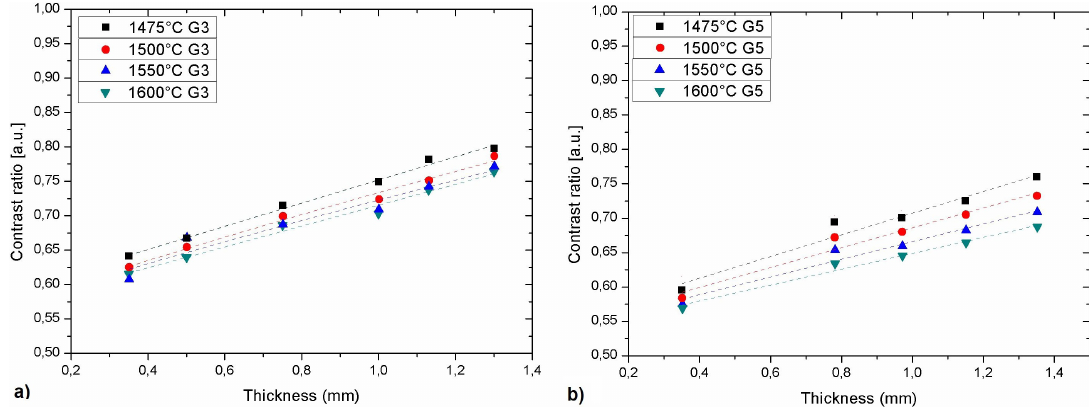
Figure 8. Contrast ratio CR of samples in regard to sample thickness: a) G3 and b) G5.